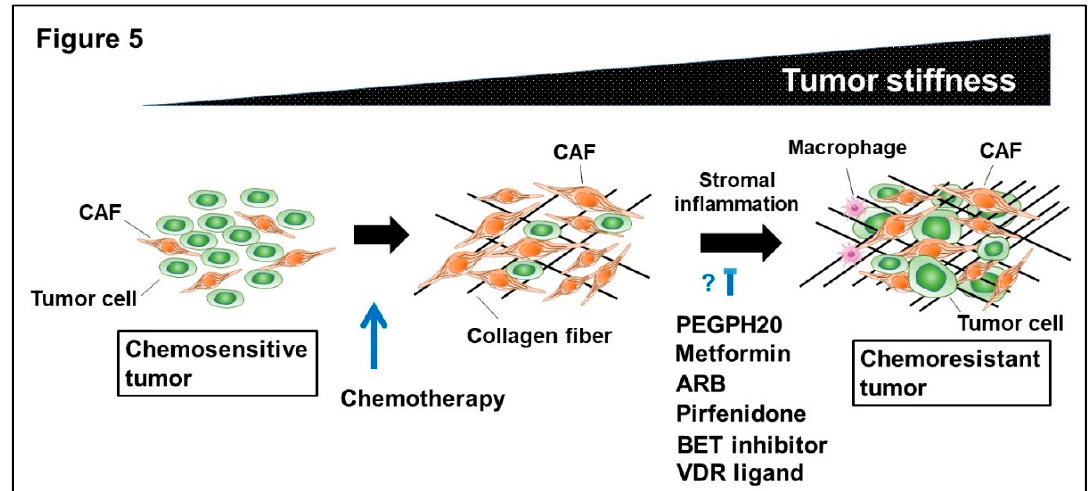
Figure 5. Schematic representation of chemoresistant tumor formation by CAFs and the potential treatment.